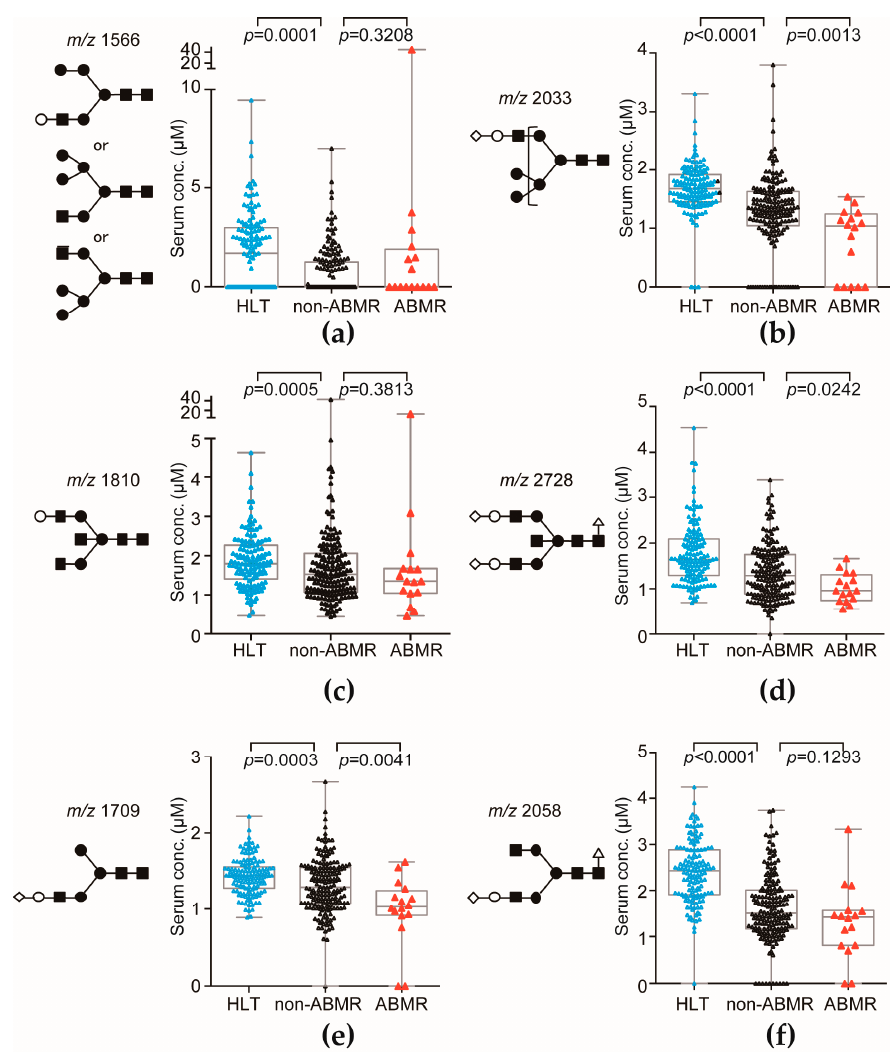
Figure 3. The levels of ABMR-associated N -glycans in the healthy volunteers (HLT) and recipients on postoperative day 1. ( a ) Serum m / z 1566 levels in the HLT (cian triangle), non-ABMR (black triangle), and ABMR (red triangle) patients; ( b ) Serum m / z 2033 levels in the HLT, non-ABMR, and ABMR patients; ( c ) Serum m / z 1810 levels in the HLT, non-ABMR, and ABMR patients; ( d ) Serum m / z 2728 levels in the HLT, non-ABMR, and ABMR patients; ( e ) Serum m / z 1709 levels in the HLT, non-ABMR, and ABMR patients; ( f ) Serum m / z 2058 levels in the HLT, non-ABMR, and ABMR patients. Putative structures of N -glycans are indicated by monosaccharide symbols. Table 3. Multivariate discriminant analysis for prediction of ABMR.